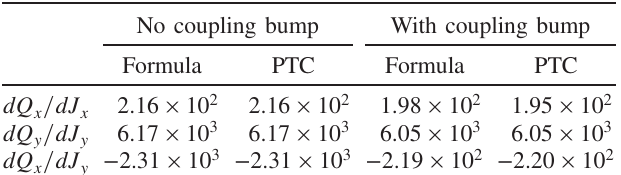
TABLE I. Amplitude detuning from a single octupole within the coupling bump in arc